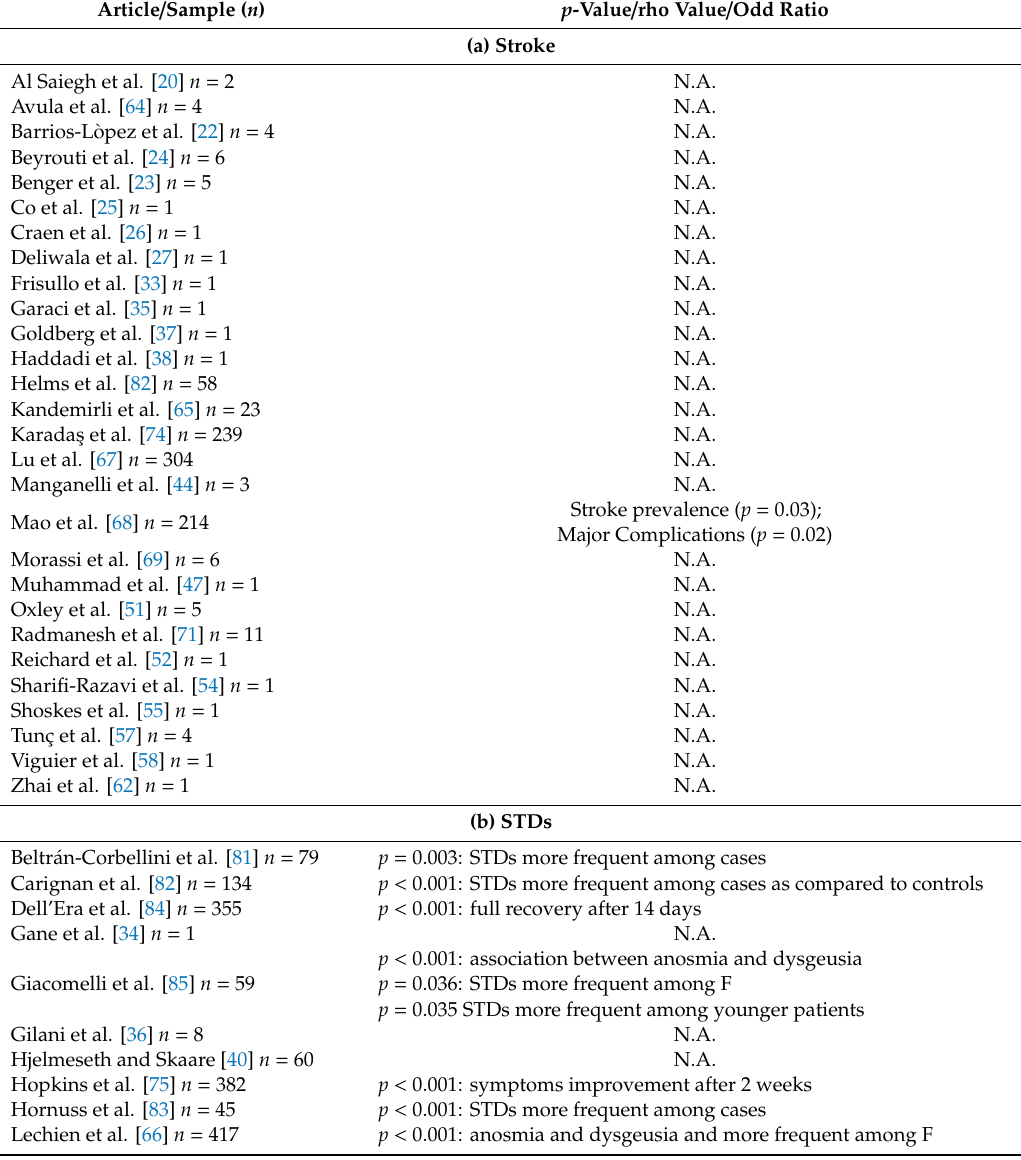
Table 1. Categorization of the studies concerning SARS-CoV-2 e ff ects on the CNS: (a) Stroke; (b) Smell and taste disorders (STDs); (c) Encephalopathy; (d) Meningoencephalitis; (e) Seizures; and (f) Other Neurological